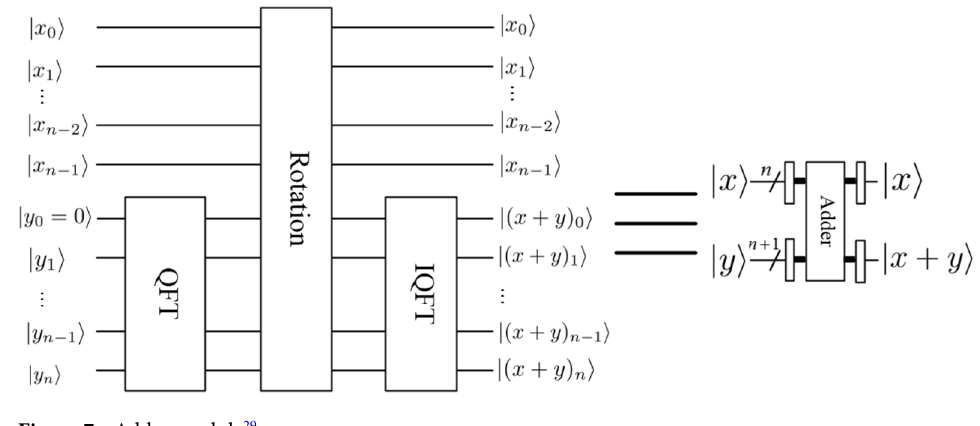
Figure 7. Adder module 29 .